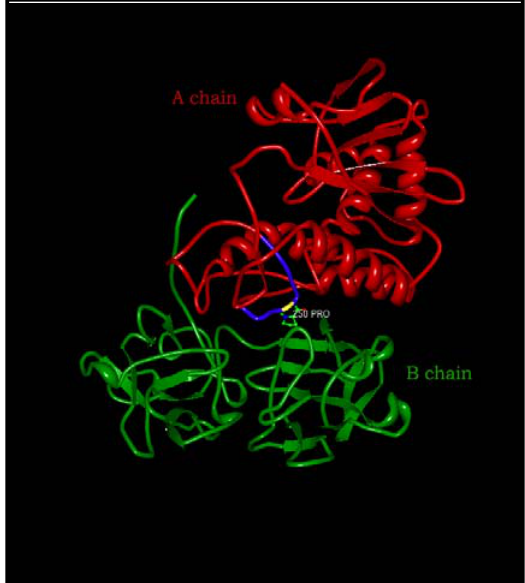
Figure 1. Crystallographic structure of ricin. The enzymatically active subunit (A-chain) is in red, whereas the binding domain (B-chain) is in green. The hydrophobic region of ricin A-chain (Val245 to Val256) is indicated in blue, proline P250 is in yellow. The structure has been obtained from the PDB protein data bank (code